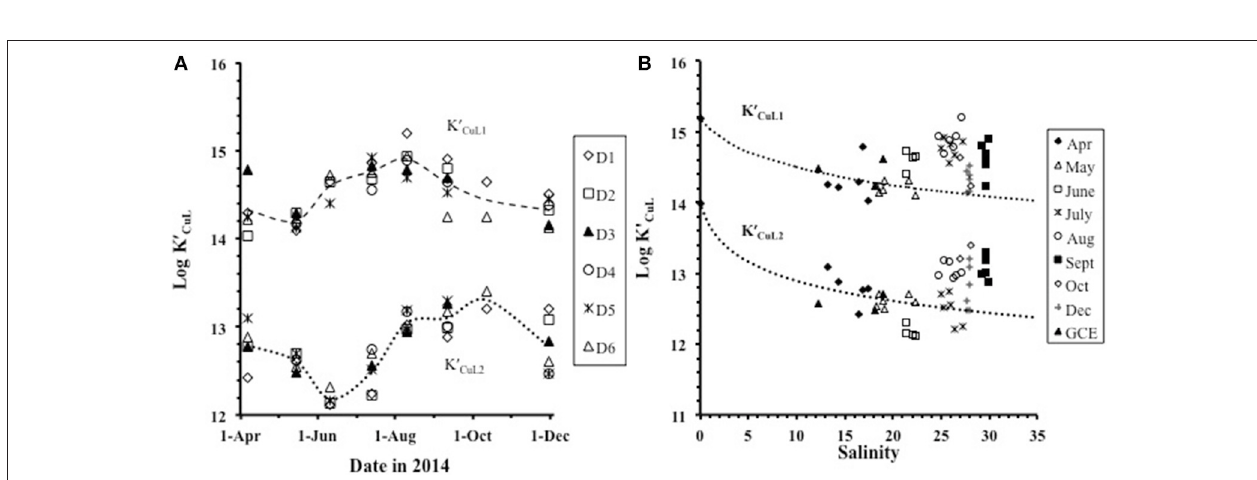
FIGURE 2 | The variation in ligand concentration with salinity for (A) the L 1 ligand class and (B) the L 2 ligand class. Both L 1 and L 2 generally decreased with increasing salinity from April to October though the data are affected by localized inputs. The GCE stations and the freshwater end-member (STN 10) sampled in April are included.